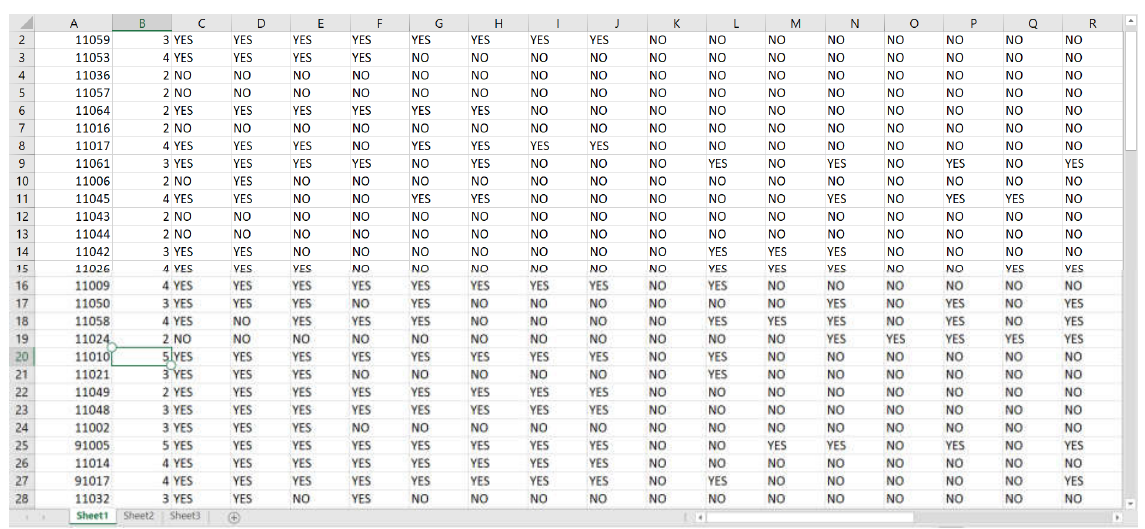
Figure 2. Data from Zoom.